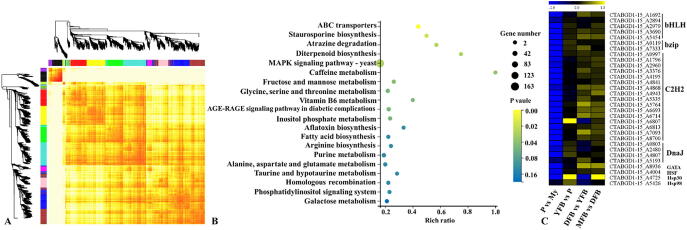
KEGG pathway and expression analyses of hub genes obtained using WGCNA. A, Hierarchical cluster tree showing the 26 co-expression modules labeled with different colors. Every leaf represents one gene. B, KEGG pathway enrichment analysis of 1386 hub genes identified by WGCNA. Pathways with P values < 0.05 were significantly enriched. C, Differential expression levels of the indicated transcription factors and heat shock protein genes obtained from hub genes in each of the four comparisons of two adjacent stages. My, Mycelial stage; P, Primordial stage; YFB, Young fruiting body stage; DFB, Developmental fruiting body stage; MFB, Mature fruiting body stage; vs, Versus.